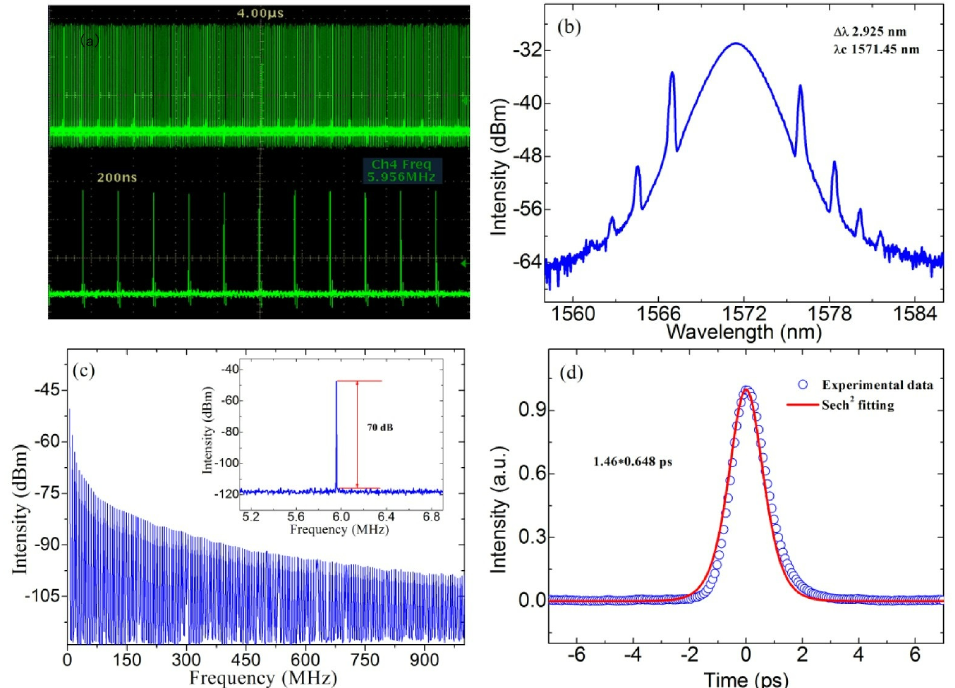
Figure 13. Typical Mode-locking output: ( a ) Output pulse train. ( b ) the corresponding spectrum. ( c ) the measured autocorrelation trace and its fitting curve. ( d ) RF spectrum. Inset: RF spectrum in 1 GHz span. Reproduced from ref. [32]. Optical Society of America, 2015.